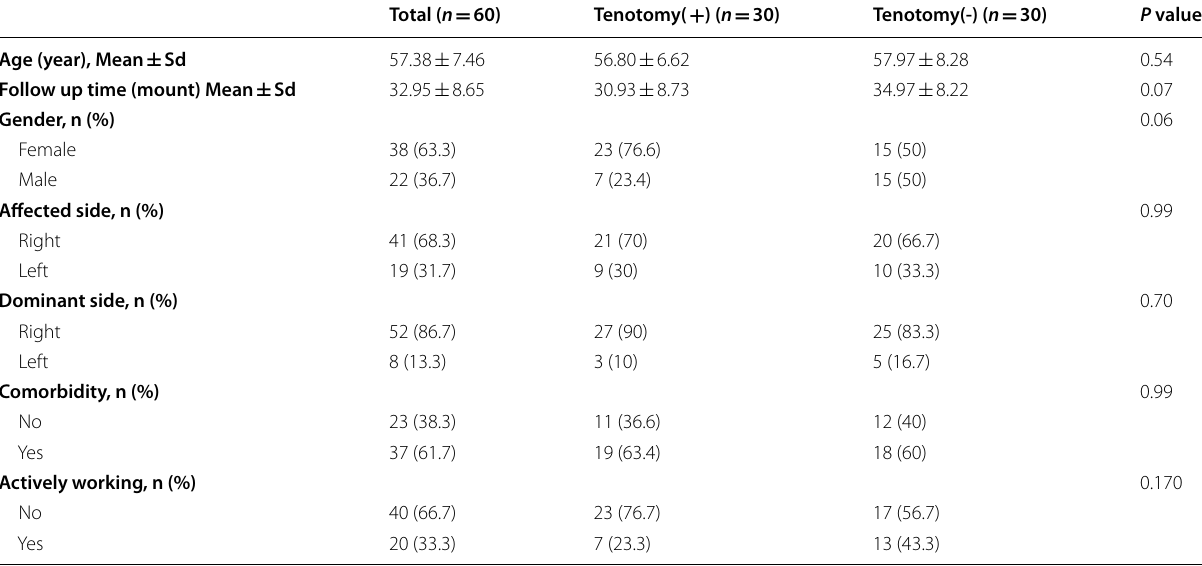
Diabetes mellitus, hypertension, goiter, asthma, chronic obstructive pulmonary disease, coronary artery